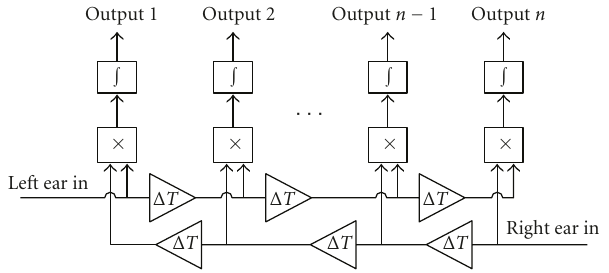
Figure 5: Je ff ress model: delay line network.